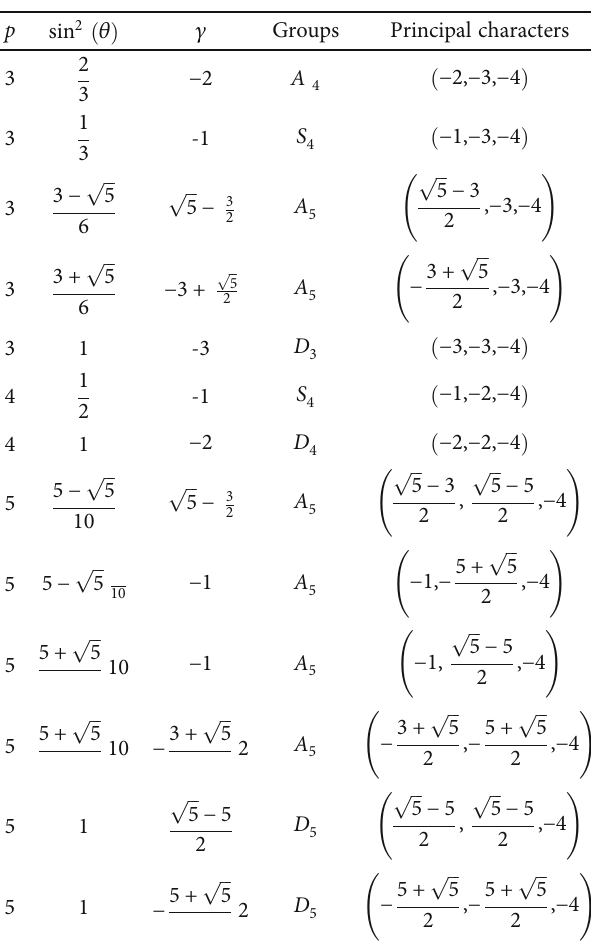
Table 1: Principal Characters: 2, p